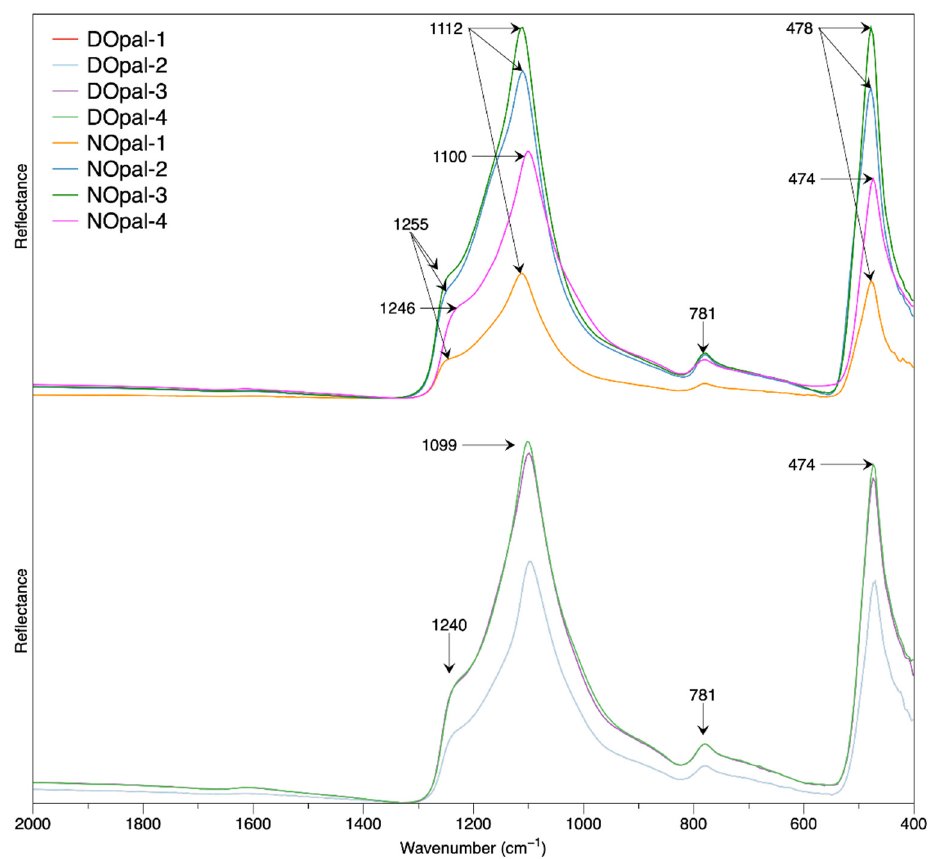
Figure 5. Mid-infrared spectra of samples. Table 2. Assignments of the infrared absorption of opal [8,9,15–18,21].